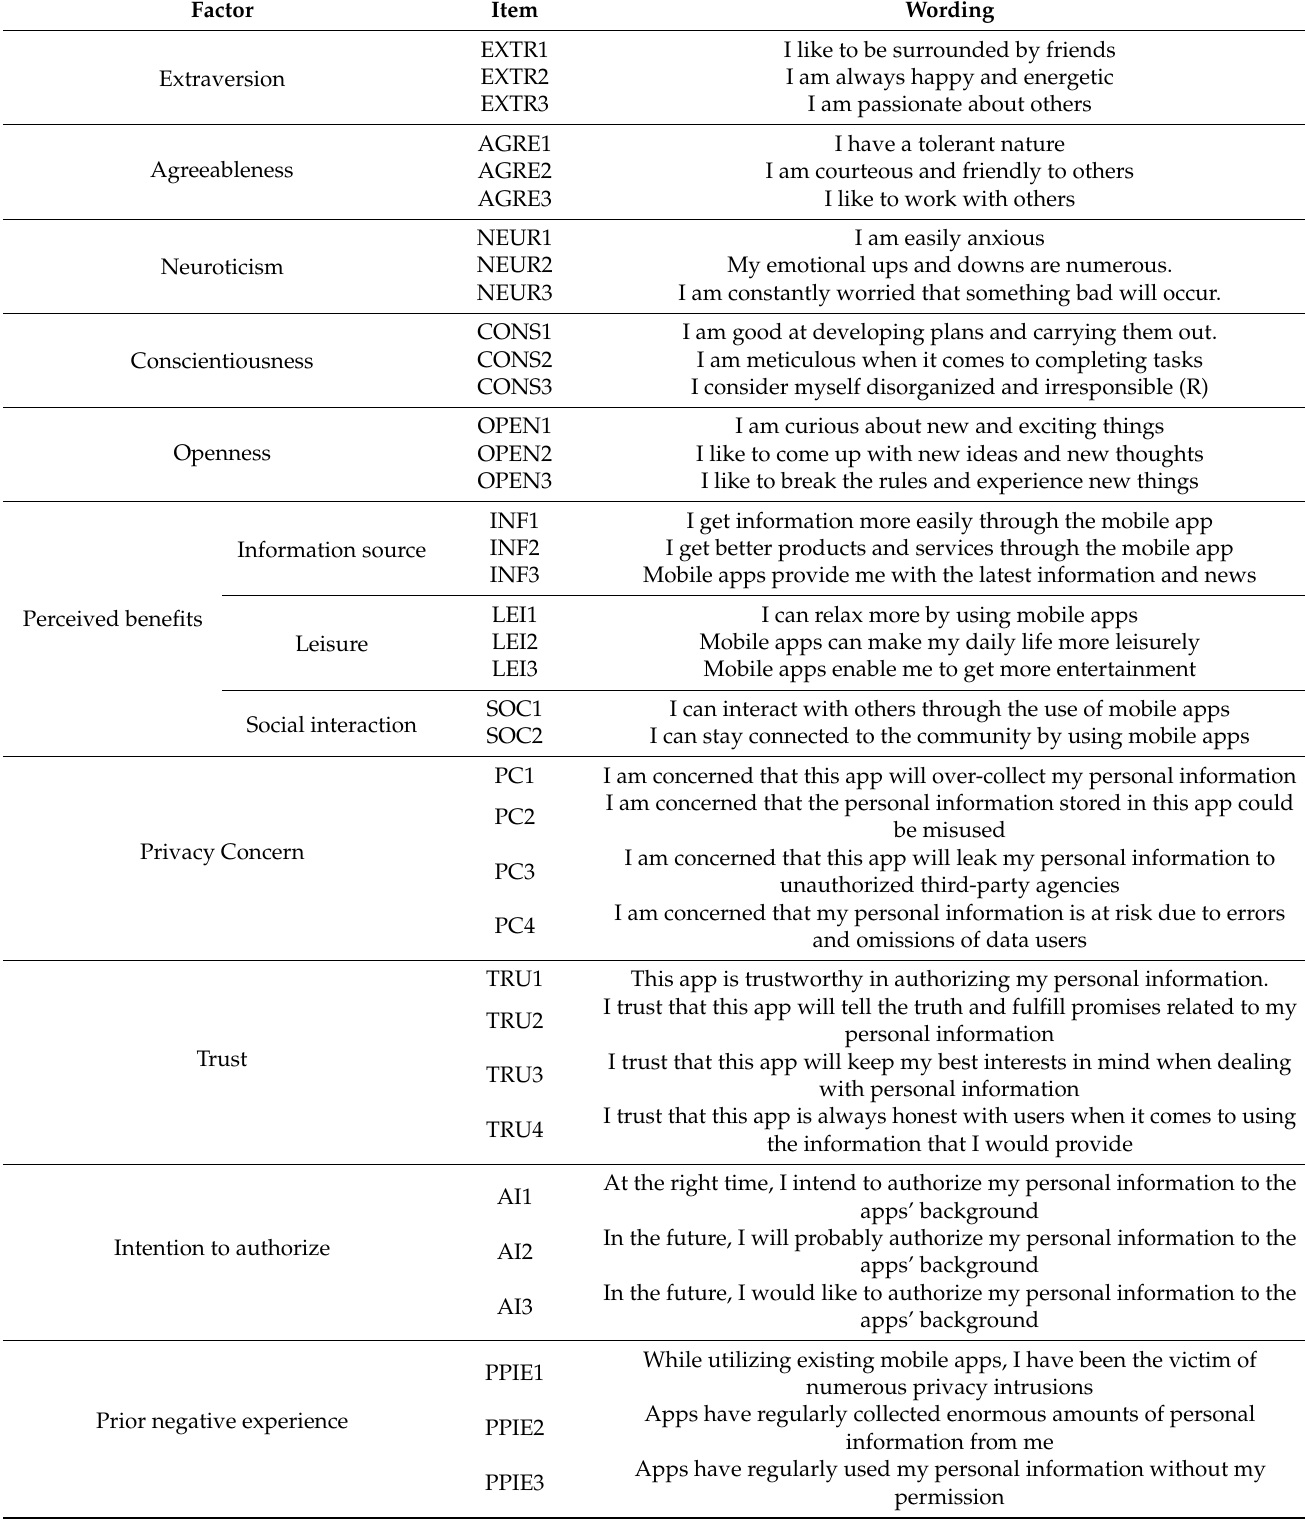
Table A2. The final items and sources of each